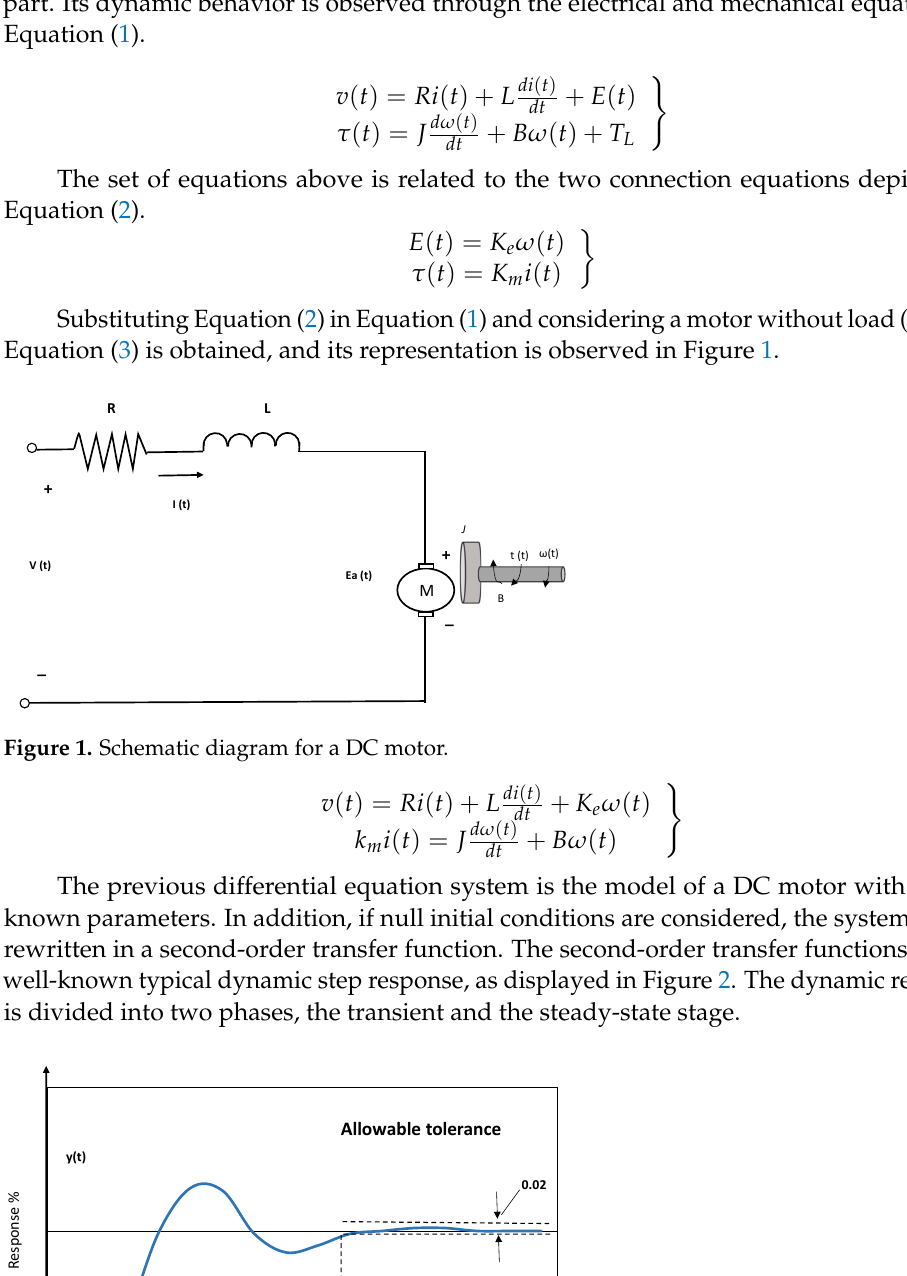
Figure 2: States in dynamic step response.